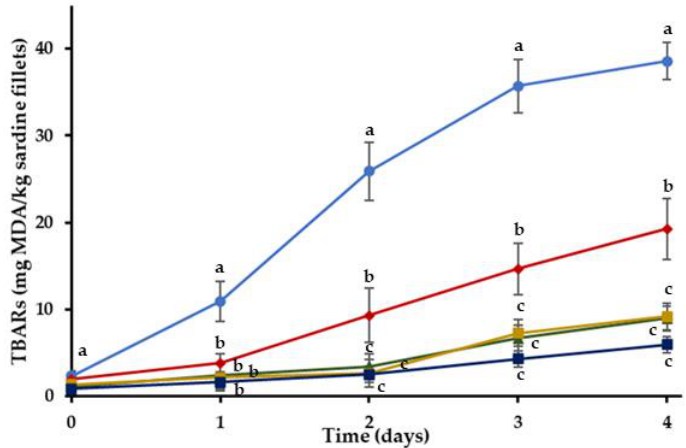
Figure 2. Oxidation values of sardine fillets with incorporated RE coating during storage at 4 °C. ( ● ) C: control-uncoated fillets; ( ♦ ) HR: hydrogel coating with RE; ( ▲ ) OR: oleogel coating with RE; ( ■ ) BGHR: bigel coating with added RE in the aqueous phase; ( ■ ) BGOR: bigel coating with added RE in the lipid phase. a–c Different letters in the same day indicate significant differences ( p < 0.05).